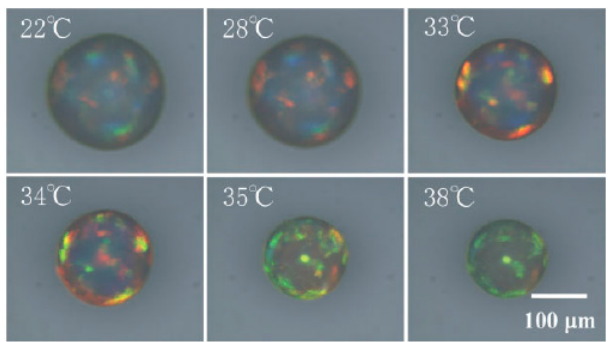
Figure 3. Photographs of the reflection at normal incidence of a thermosensitive PNIPAm-immobilized colloidal crystal sphere at various temperatures. Reproduced with permission from [27].